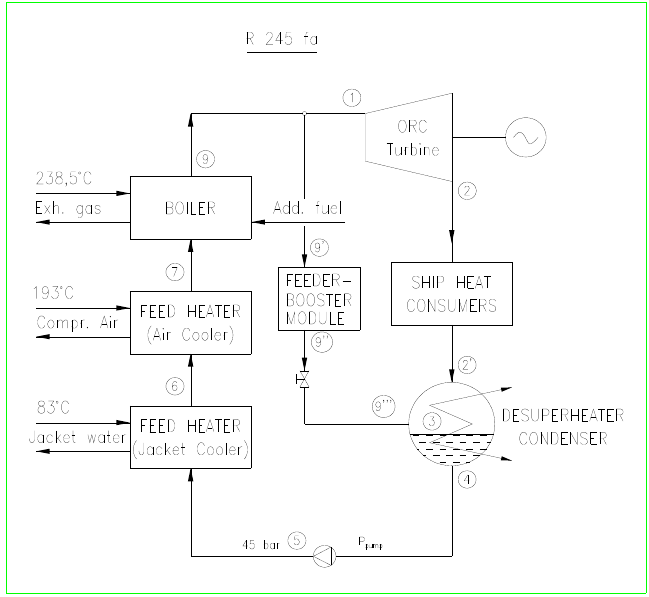
Figure 3. Schematic diagram of the CHP plant with R245fa fluid [5,15].